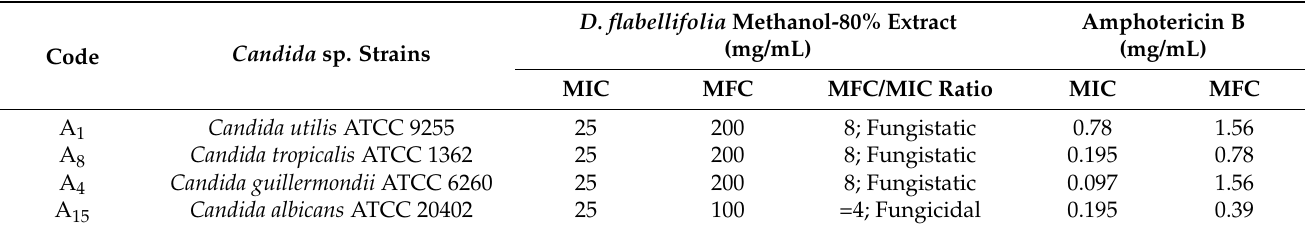
Table 4. Determination of MICs, MFCs, and MFC/MIC ratios for Candida species as compared to Amphotericin